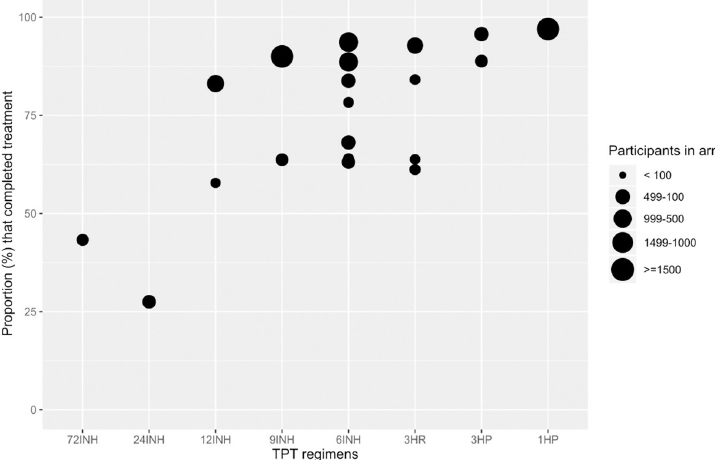
Fig 3. Proportion of TPT completion by individual regimens. Notes: No information was available for completion of 36H; information on placebo or no treatment is not shown as duration varied. TPT, tuberculosis preventive therapy.